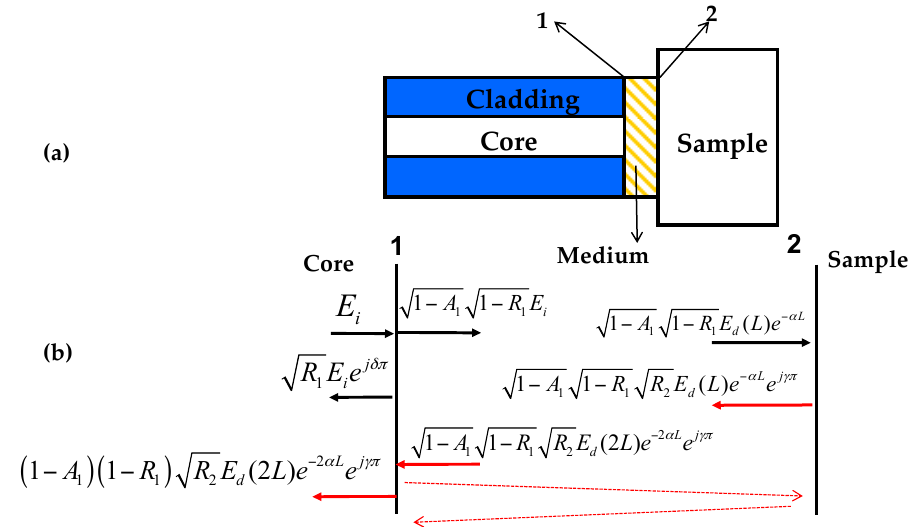
Figure 1. ( a ) Basic structure of the sensing head; ( b ) The field amplitudes at the two reflection